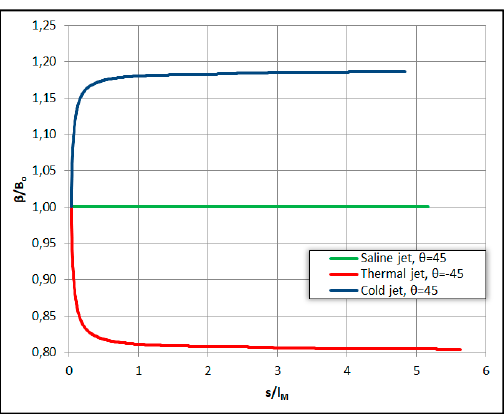
Figure 14. Comparison between negatively buoyant jets regarding their buoyant power β / Β ο